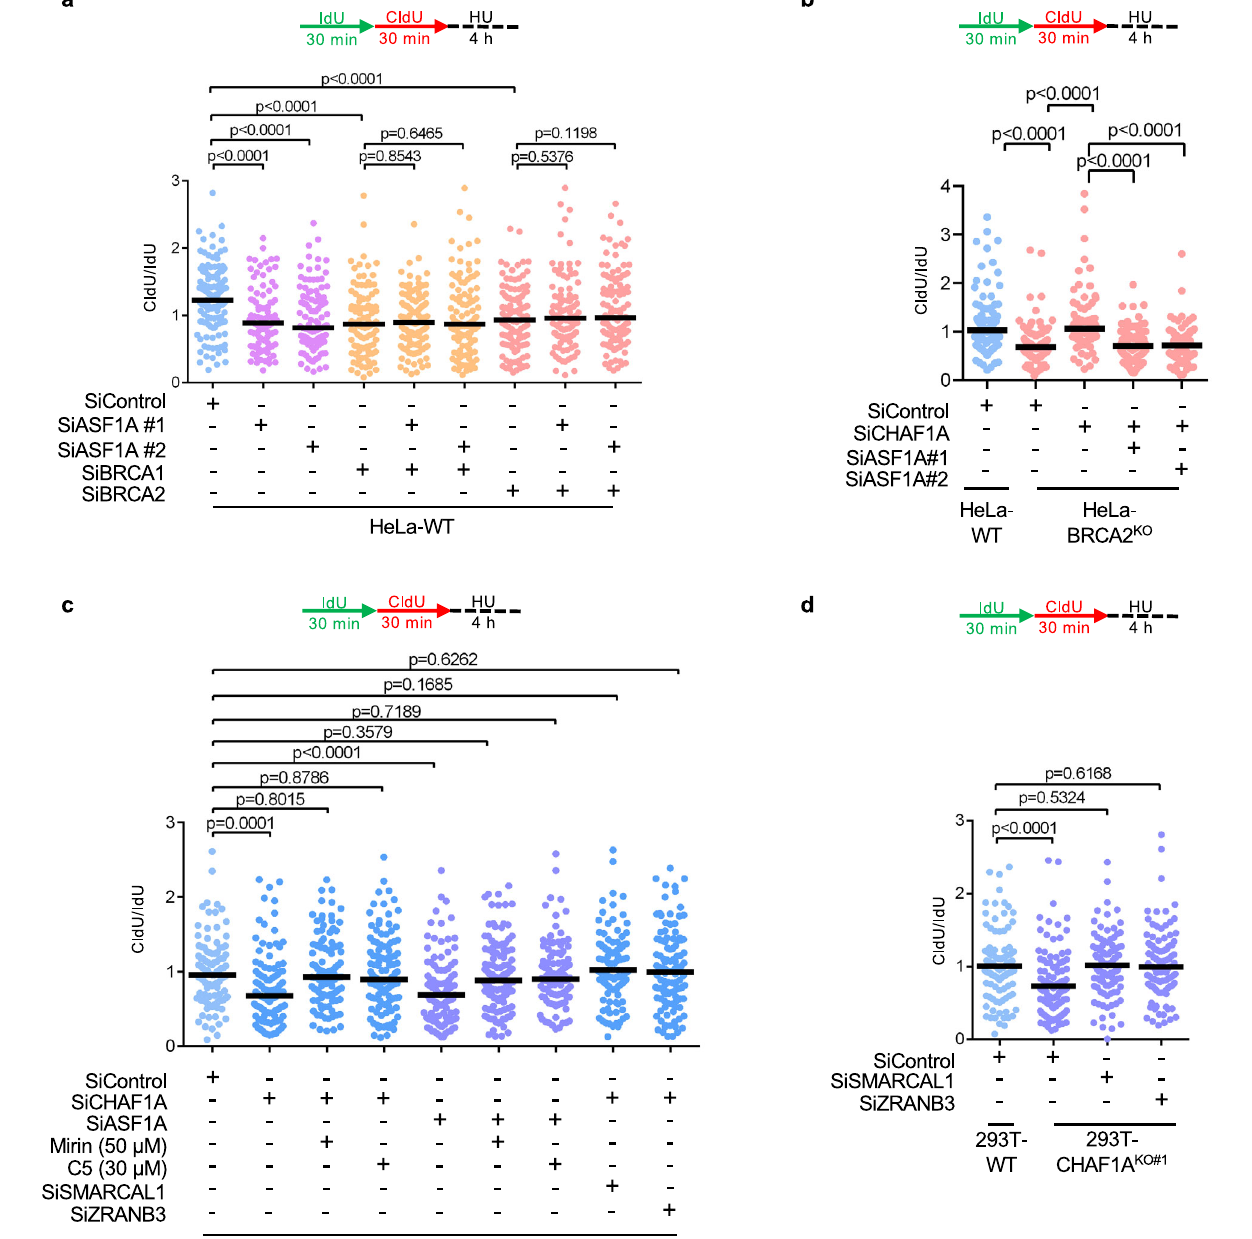
fi bercombingassayshowingthatinhibitionofnucleasesMRE11(bytreatmentwith mirin) or DNA2 (by treatment with C5), or co-depletion of DNA translocases SMARCAL1 and ZRANB3, suppresses HU-induced fork degradation caused by CHAF1A or ASF1A loss in HeLa cells. The ratio of CldU to IdU tract lengths is presented, with the median values marked on the graph. The p -values (Mann – Whitneytest,two-tailed)arelistedatthetop.Aschematicrepresentationof the DNA fi ber combing assay conditions is also presented. Western blots con- fi rmingtheco-depletionareshowninSupplementaryFig.3e. d DNA fi bercombing assay showing that SMARCAL1 or ZRANB3 depletion suppresses HU-induced fork degradationin293T-CHAF1A KO cells. The p -values (Mann – Whitney test, two-tailed) are listed at the top. A schematic representation of the DNA fi ber combing assay conditions is also presented.Westernblots con fi rming the knockdowns areshown in Supplementary Fig.